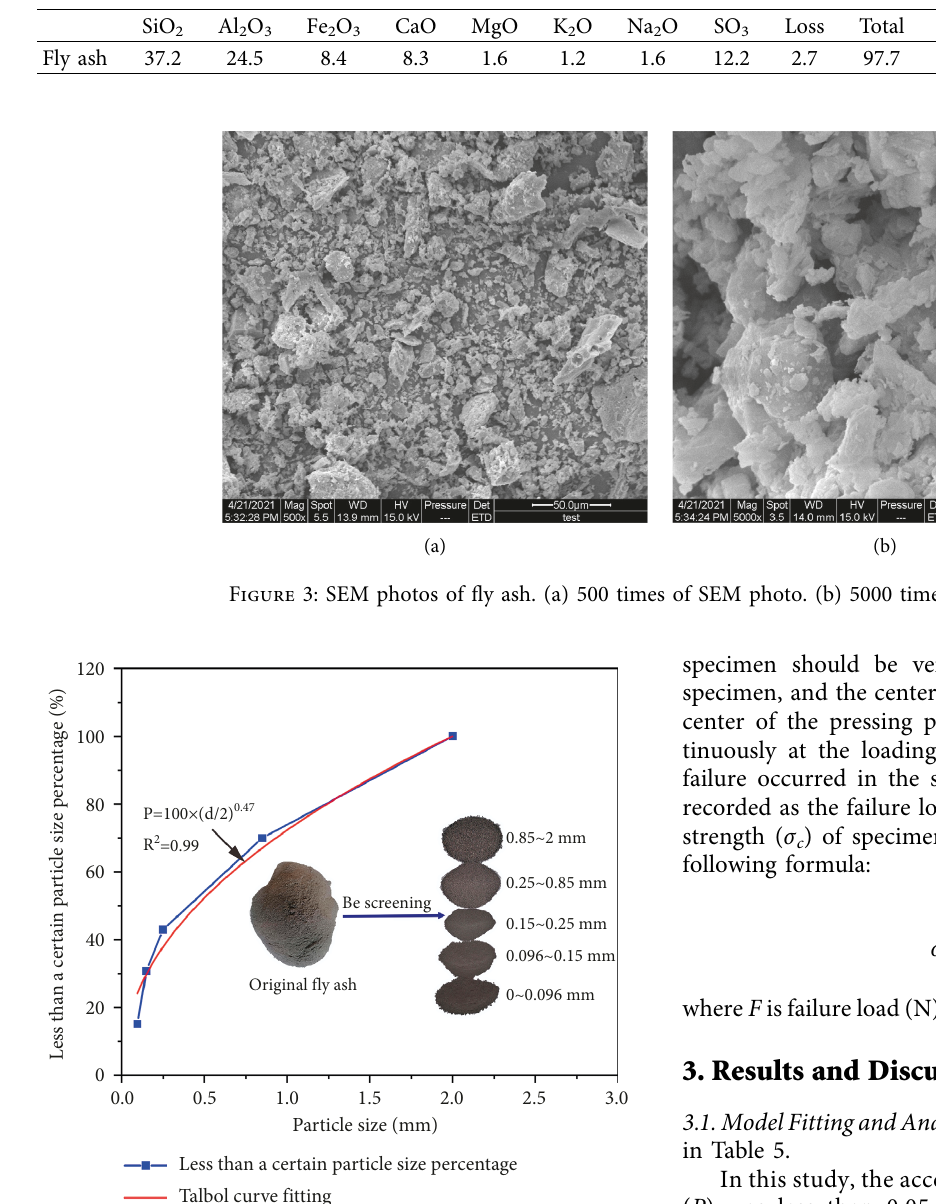
Table 2: Chemical composition and physical properties of fly ash.